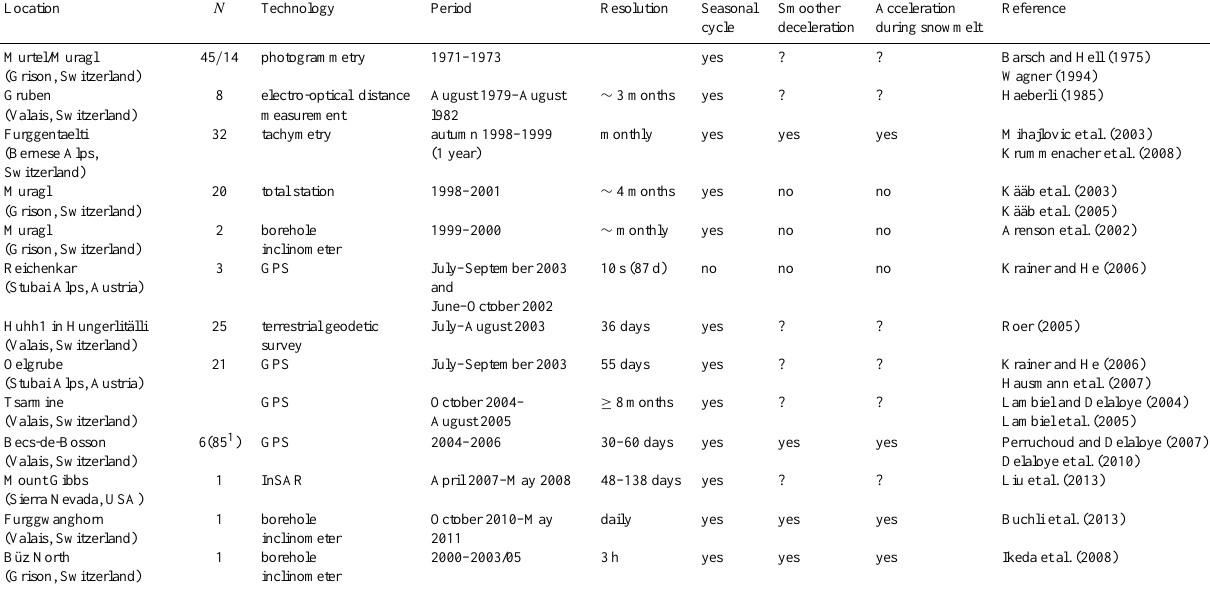
Table 1. Overview of previous studies on the intra-annual variability in rock glacier movement found in literature. For each study (if available) the following information is listed: name and location of investigated rock glacier(s) (location), the number of measurement points ( N ), the surveying technology (technology), the observation period (period), and the temporal resolution (resolution). In addition, it is indicated for each study whether the following observations have been made (yes: observed; no: not observed; ?: no statement): a seasonal cycle of the movement (seasonal cycle), a smoother seasonal deceleration than acceleration (smoother deceleration), a seasonal acceleration beginning during the snowmelt period (acceleration during